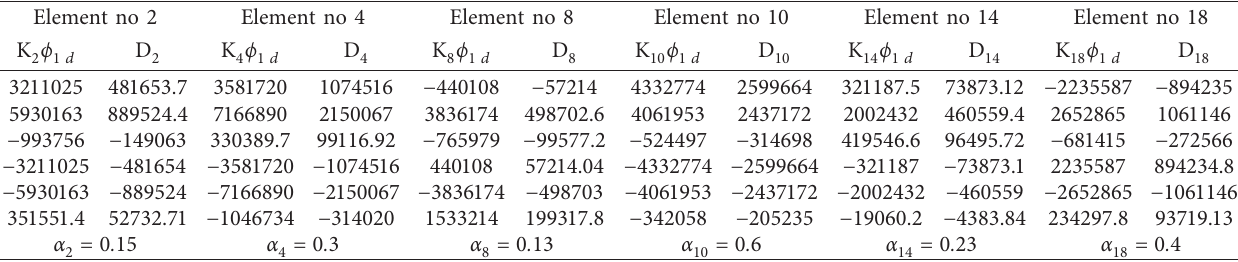
Table. 3: The evaluated damage